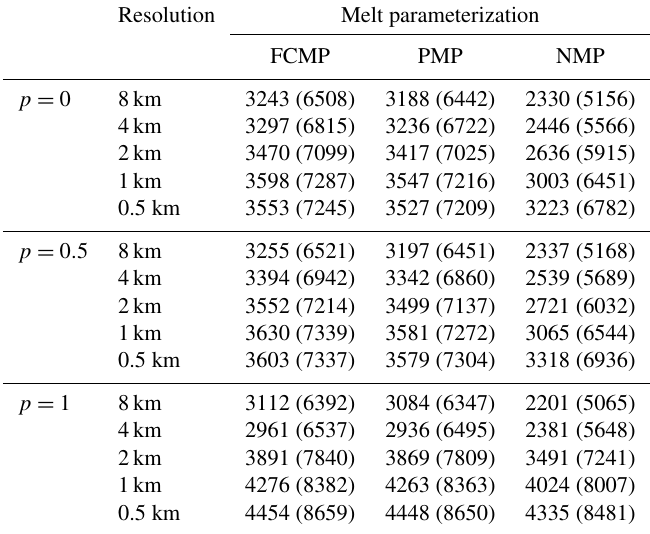
Table 4. Loss in IMAF (Gt) at the end of experiment Ice1rr for all values of p and melt rate parameterizations. The loss in total ice mass (Gt) is shown in parentheses.